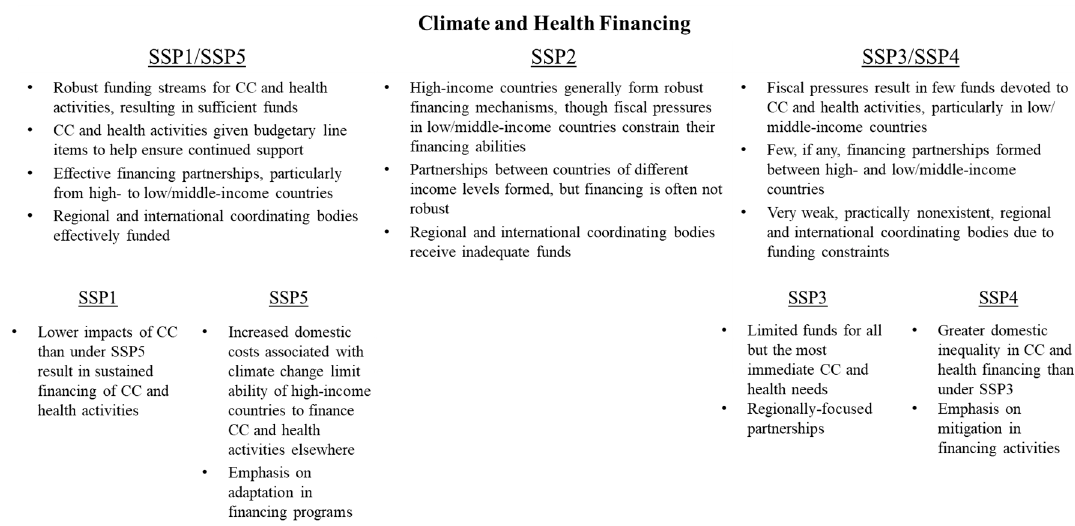
Figure 8. Variation in climate and health financing conditions across SSPs.